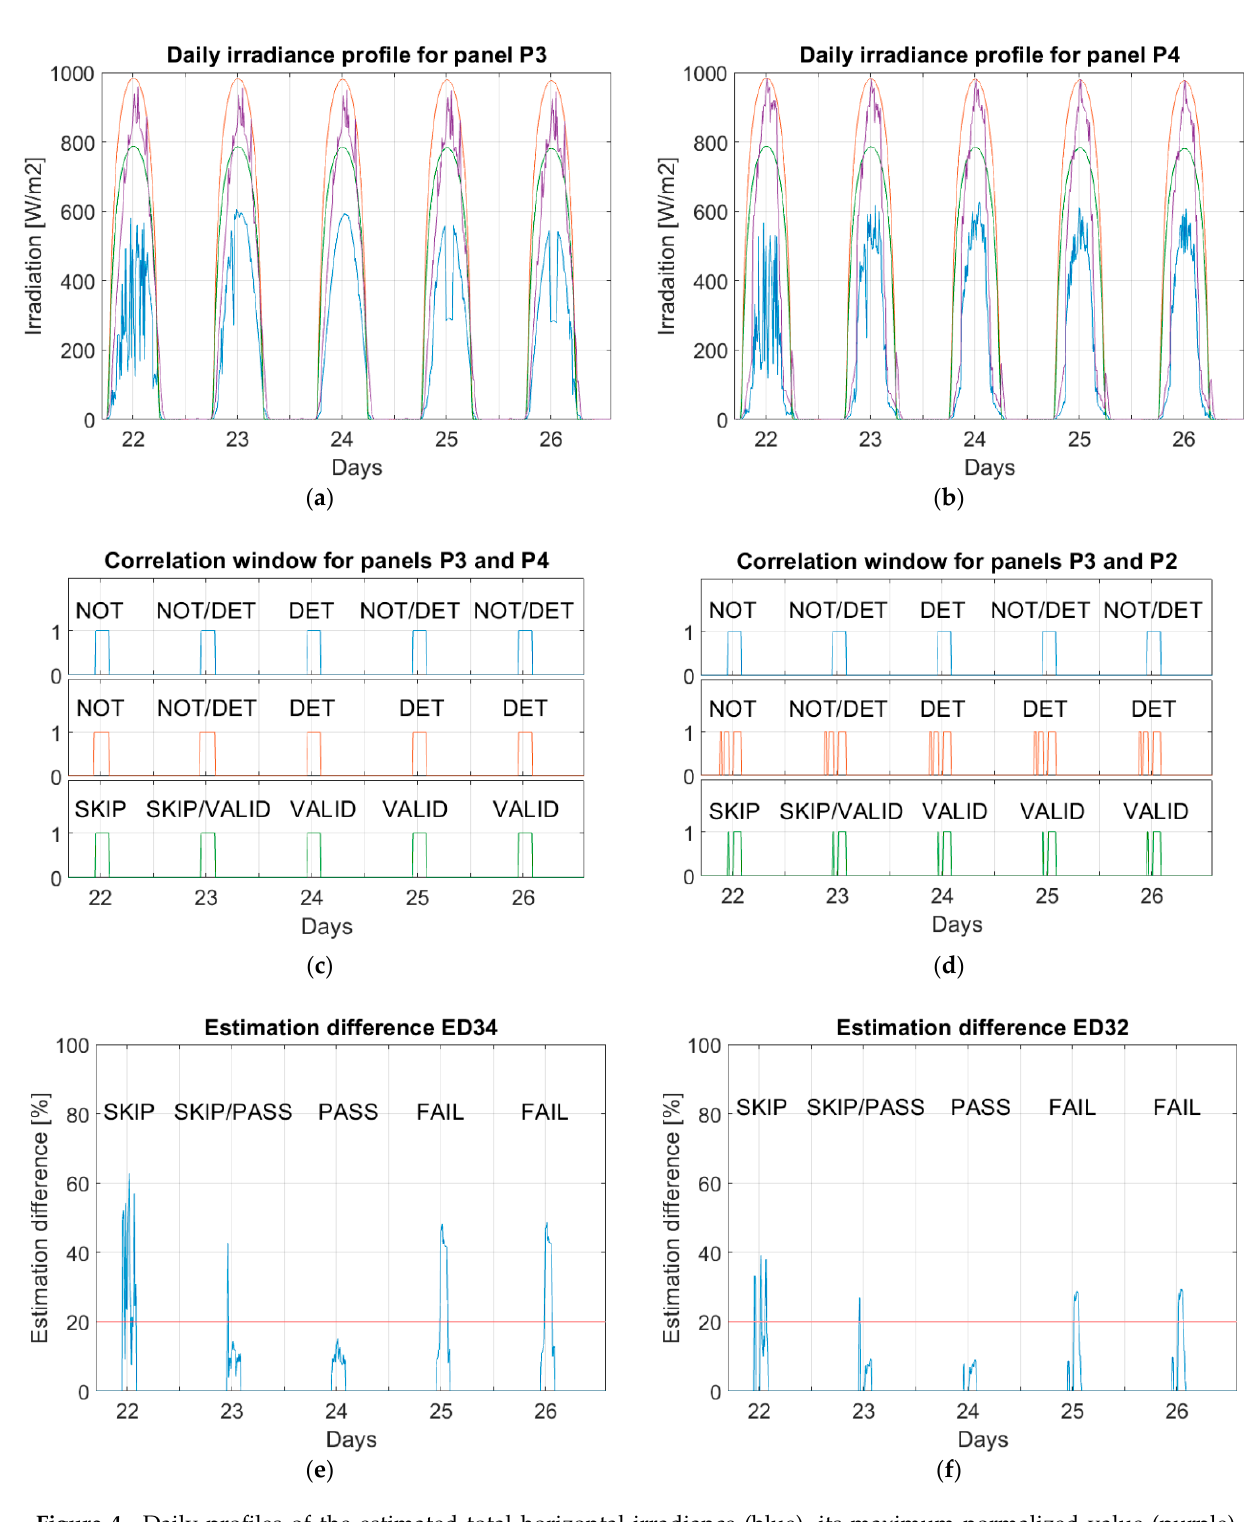
Figure 4. Daily profiles of the estimated total horizontal irradiance (blue), its maximum normalized value (purple), its reference irradiance value (red), and its boundary value for clear-sky conditions (green) for panel 1 ( a ) and panel 2 ( b ); correlation window CW 3 (top), correlation window CW 4 (middle); and cross-correlation window CW 34 (bottom) ( c ); correlation window CW 3 (top), correlation window CW 2 (middle); and cross-correlation window CW 32 (bottom) ( d ); estimation difference factor values ED 34 ( e ); estimation difference factor values ED 32 ( f